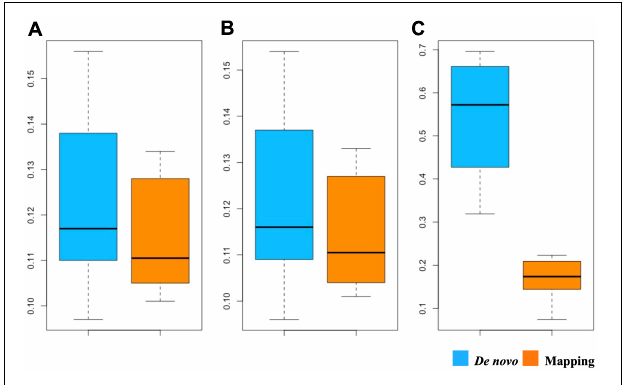
FIGURE 3 | Boxplot showing the relationship between π (A) , expected heterozygosity (B) and F IS (C) using SNPs obtained by de novo and mapping.